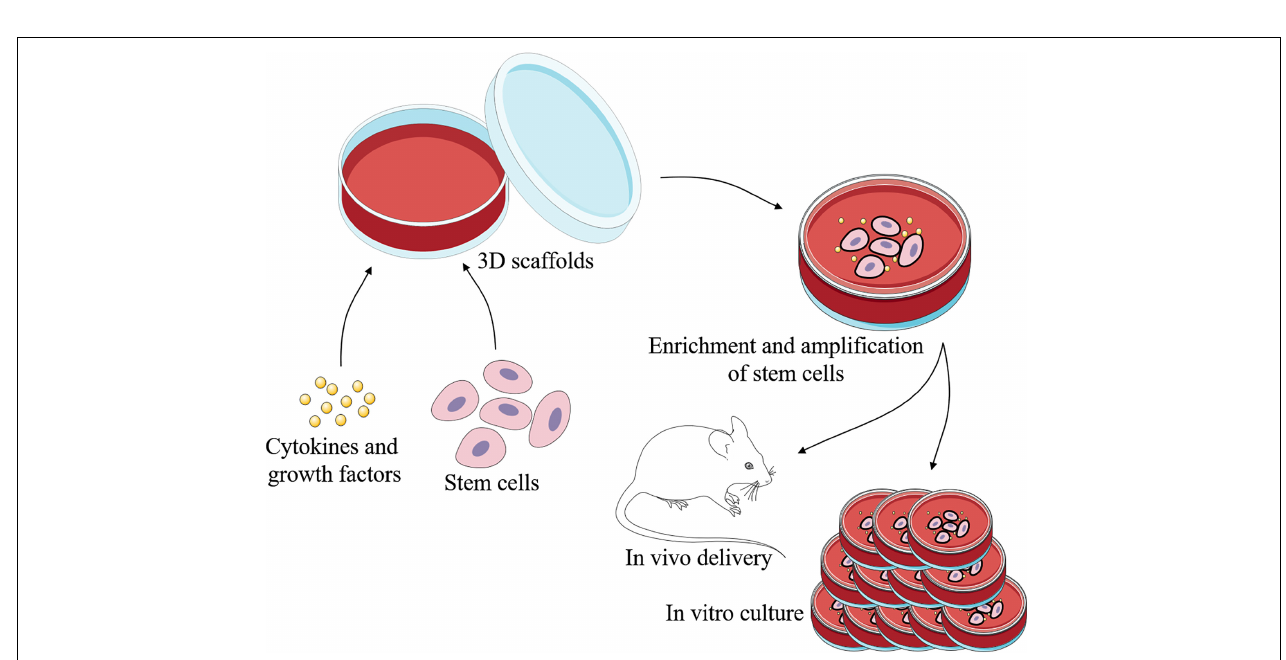
FIGURE 2 | Schematic representation of regeneration of ESGs. With the 3D scaffolds, specific cells can be induced by specific cytokines and growth factors to differeniate into sweat gland-like cells. There are three main types of cells that may be used to repair and regenerate ESGs: ESG-derived stem cells, non-sweat gland-derived stem cells, and induced pluripotent stem cells. This process can take place in vivo or in vitro .